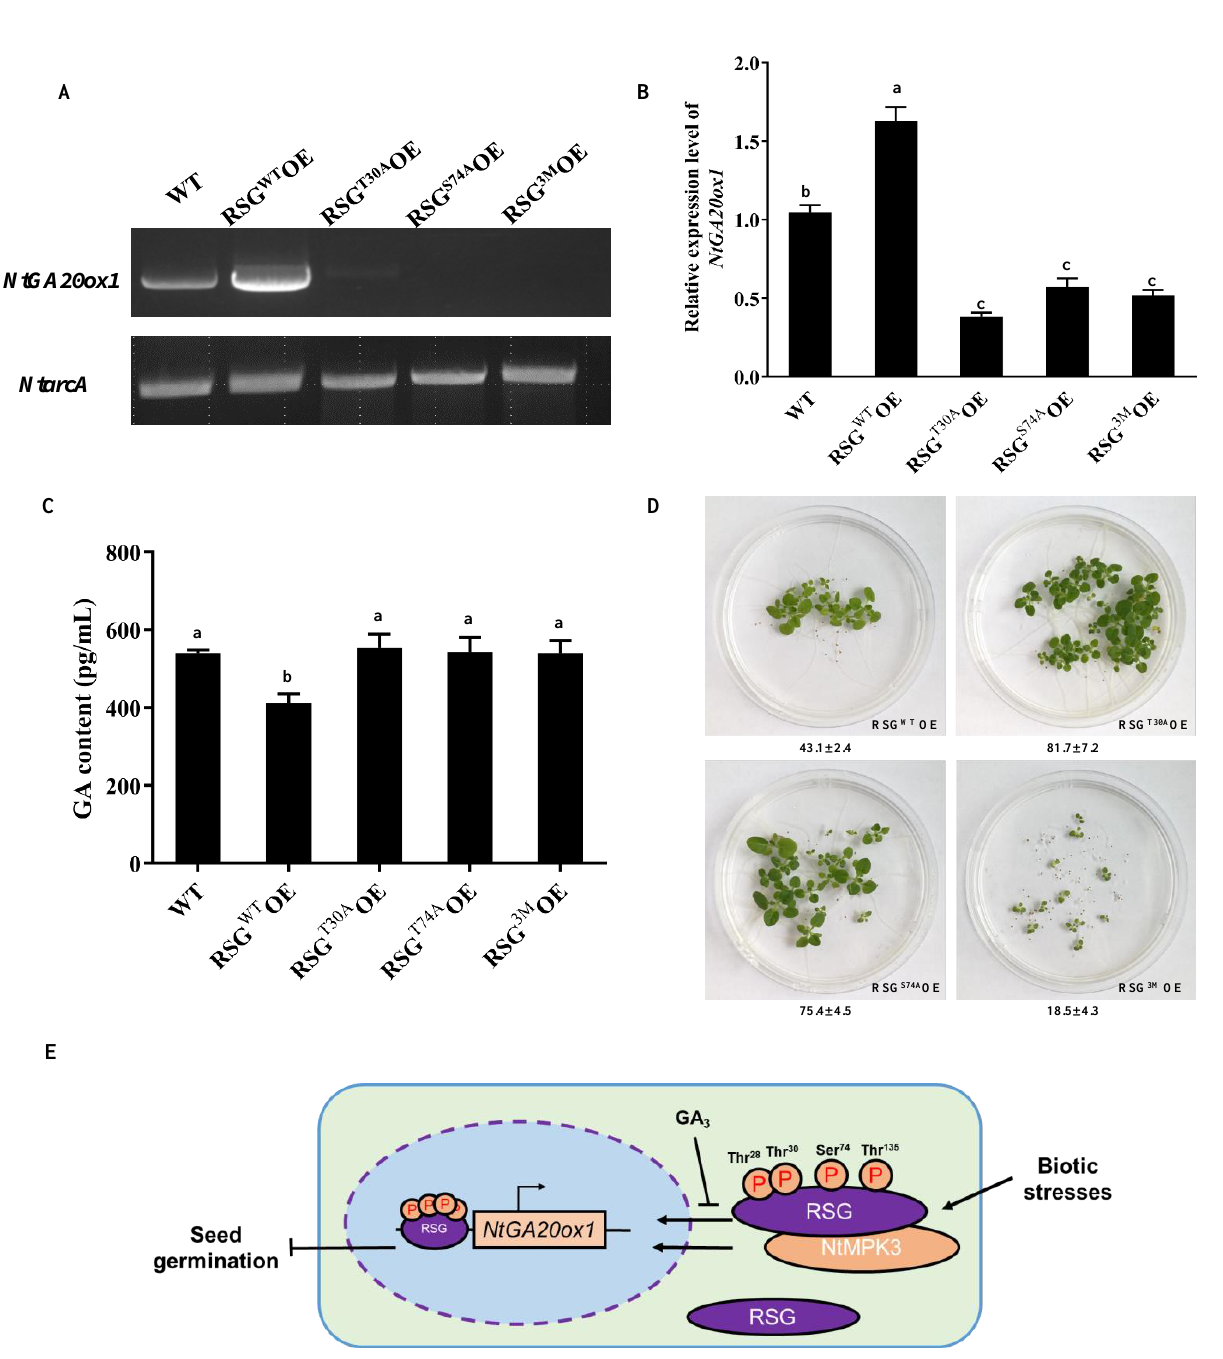
Figure 7. MAPK-associated phosphorylation sites in RSG regulates its function as a transcrip- tional factor. ( A , B ) Semi-quantitative PCR analysis of NtGA20ox1 expression in transgenic tobacco. ( C ) Detection of GA contents in transgenic tobacco overexpresses RSG or its related mutants. The values are mean ± standard deviation, followed by the same letter within a column not being signifi- cantly different, as determined by Duncan’s multiple range test ( p < 0.05). ( D ) Seeds of transgenic tobacco overexpressing RSG or its relative mutants were germinated in MS medium. The values at the bottom of panels indicate the germination ratio calculated from three independent plates. Three biological replicates were performed for each assay with similar results. ( E ) Schematic representation of the main idea of this research.